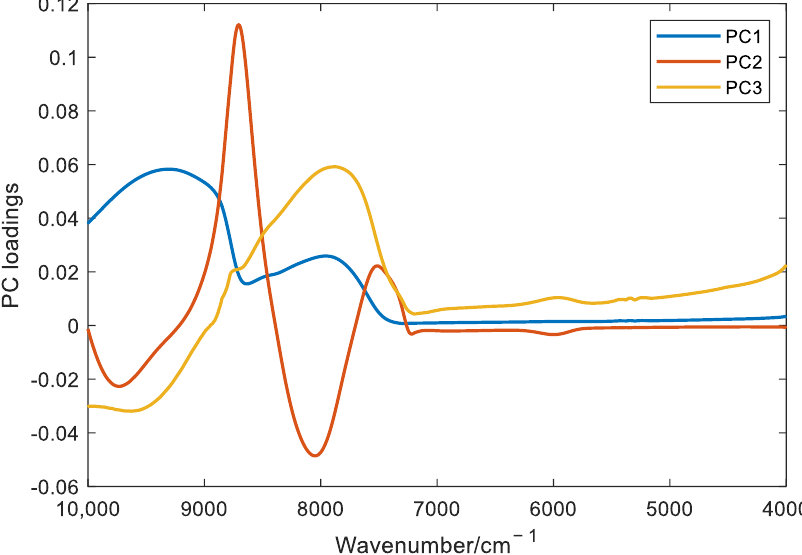
Figure 3. PC loadings of filtered transmittance spectral data.